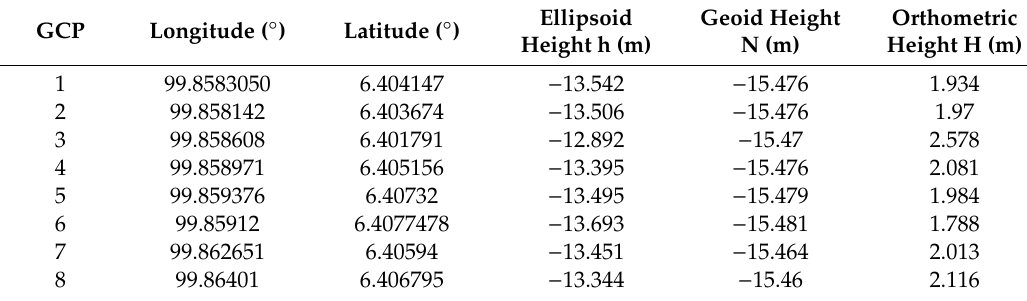
Figure 3. ( A ) Ground Control Points (GCP) distributions at the study area; ( B ) GCP 6 on the ground surface; ( C ) GCP 8 on the ground surface. Table 2. Details of GCPs at the study